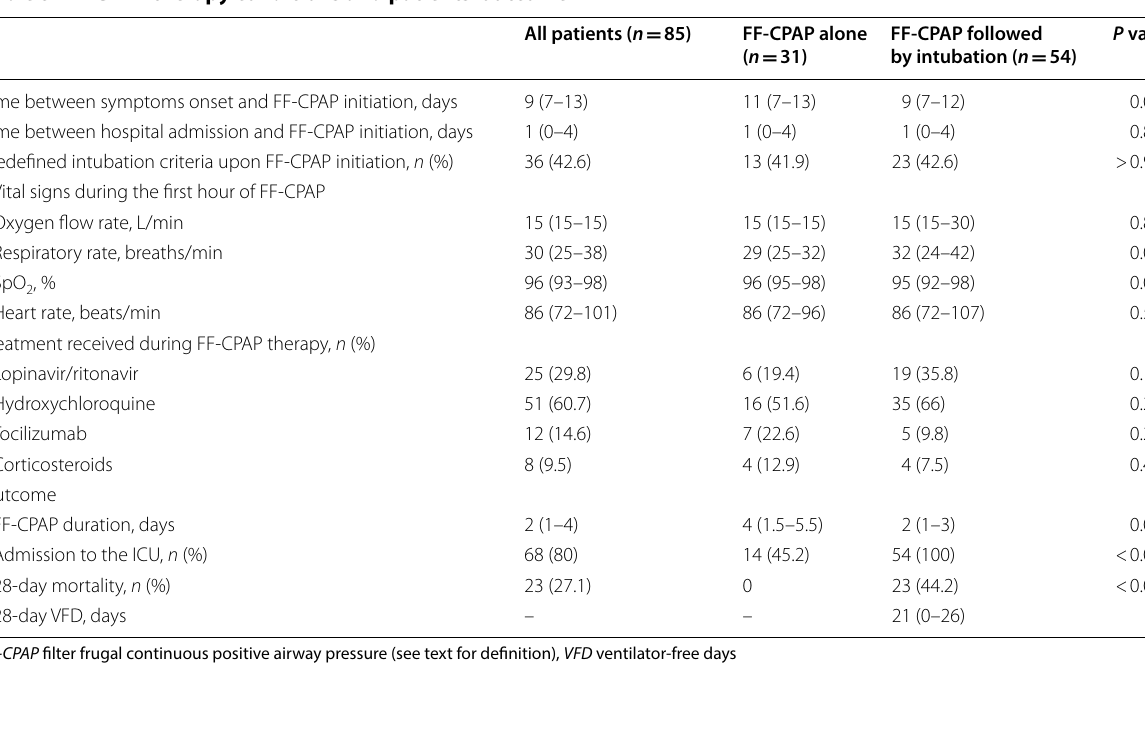
Table 3 FF-CPAP therapy conditions and patients’ outcome